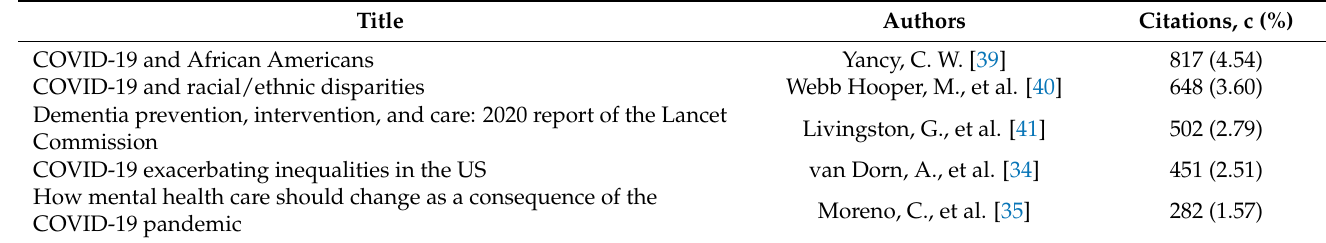
Table 7. The list of articles with citation frequencies larger than 100 (c = 17995).